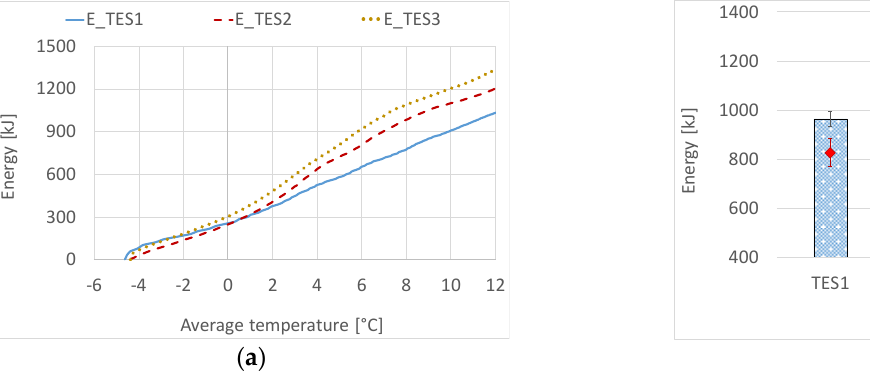
Figure 7. Energy and power during the discharging process: ( a ) energy discharged against average